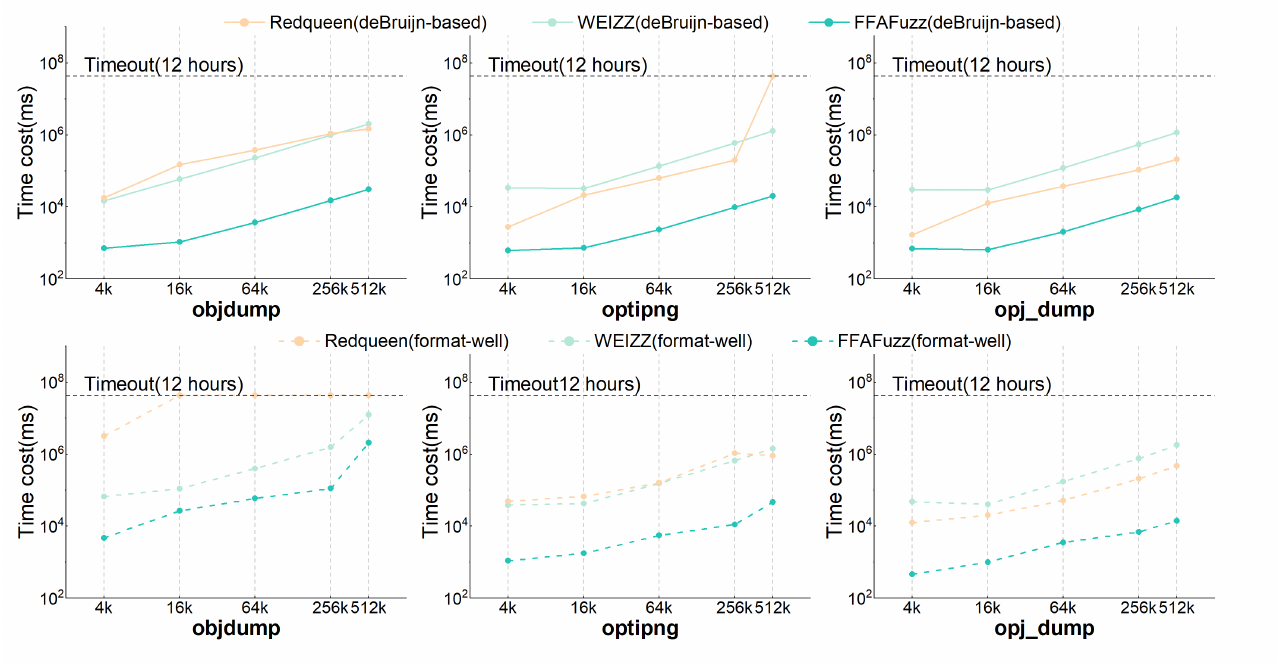
Figure 10. The time overhead of dependency recognition by various compared